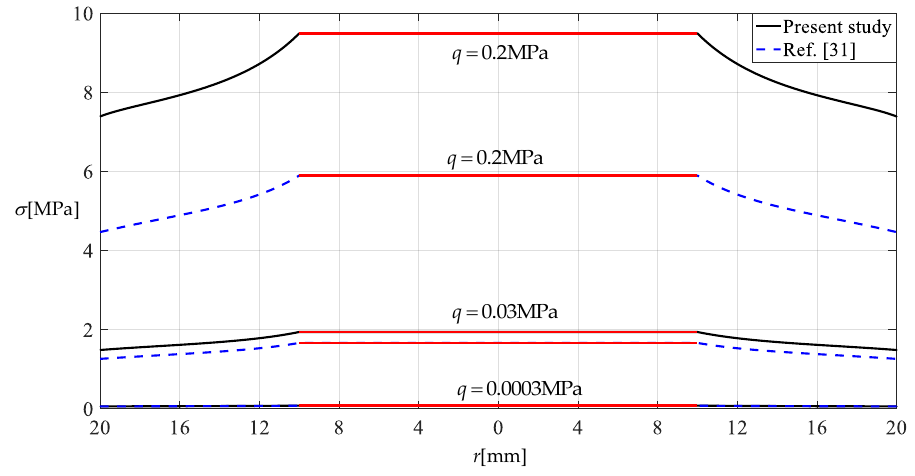
Figure 13. Variation of stress difference with load q .